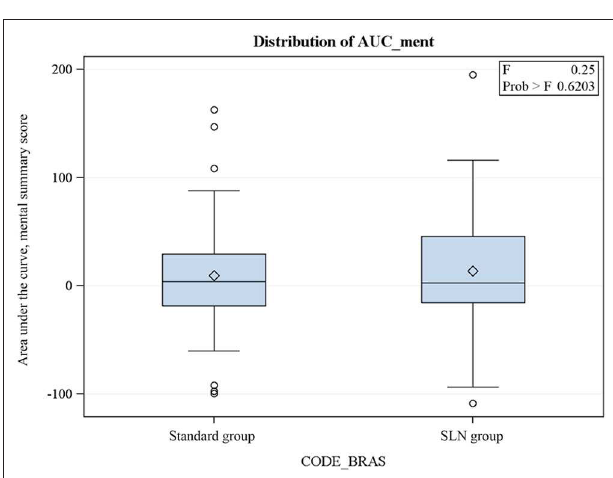
FIGURE 2 | SF36 mental subscore: area under the curve (AUC) of the evolution of the score from the preoperative trough the 3 postoperative visits.